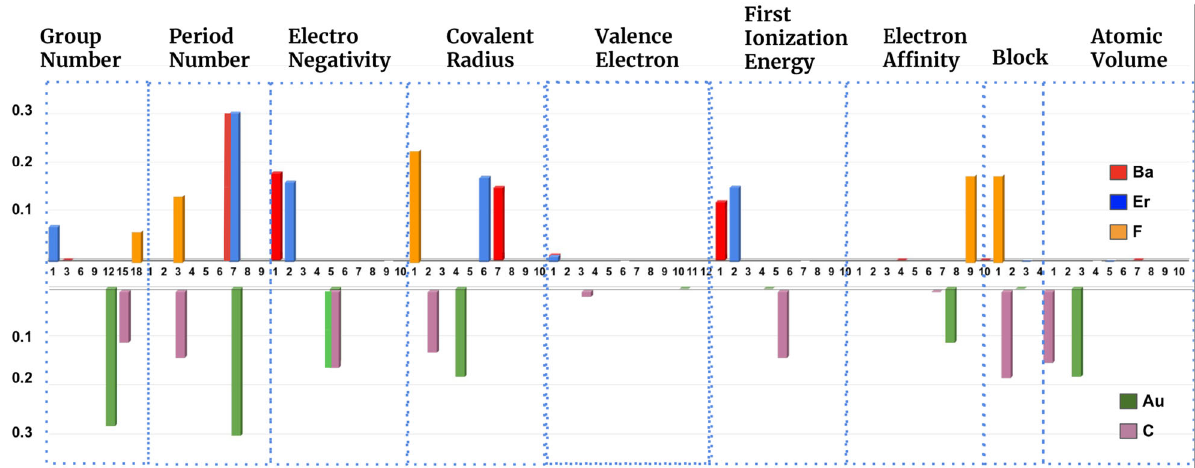
Fig. 4 Feature selector values corresponding to atom features after trained on Formation Energy tagged data. The top bar chart represents the feature weights of BaEr 2 F 8 and the one below represents the feature weights of